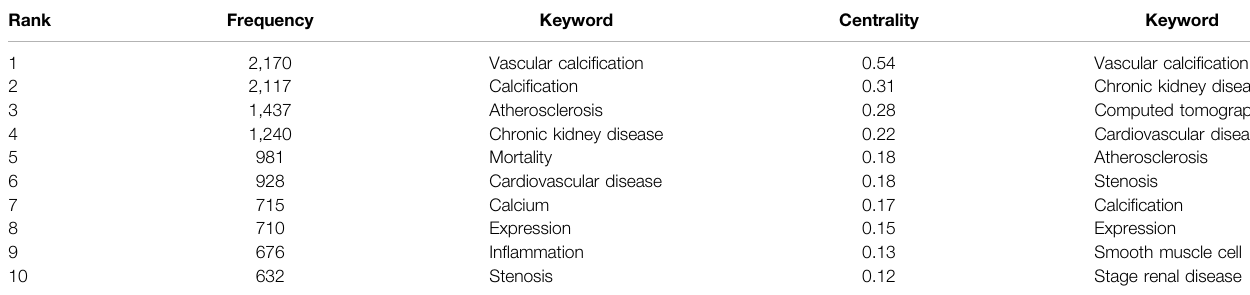
TABLE 7 | Top 10 keywords by frequency and